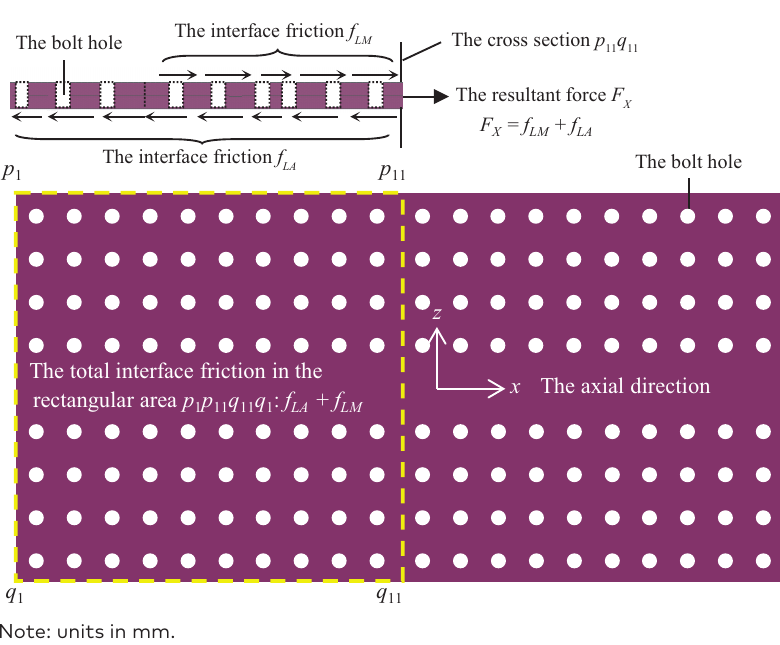
Figure 9. The calculation method of interface friction